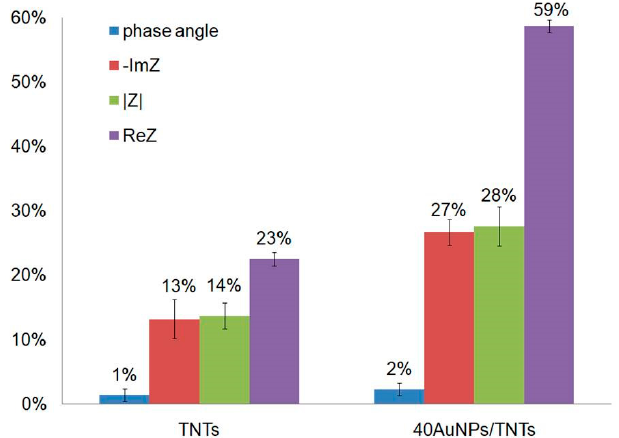
Figure 8. The values of electrochemical parameters with the calculated percentage change in value due to 30 min BSA deposition on TNTs and 40AuNPs/TNT arrays.